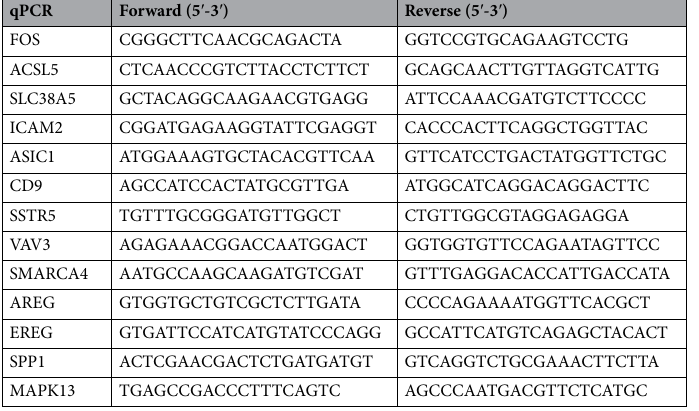
Table 1. Primer sequences used for